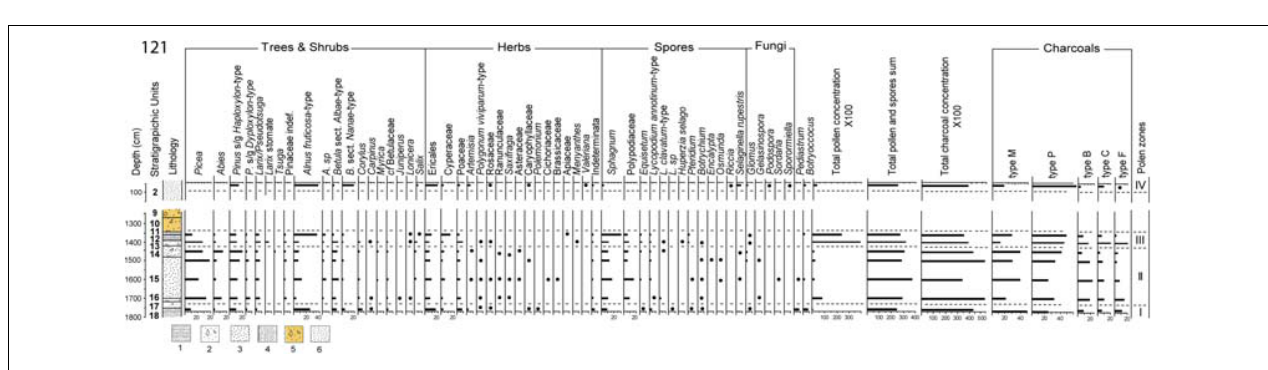
FIGURE 5 | Percentage pollen, spore, and non-pollen-palynomorph diagram of site 120 (for location see Figure 1B ). 1 – greenish-brownish pebble bed with coarse sand and fine-sand loam; 2 – ferruginous pebble bed with coarse sand; 3 – yellowish-green pebble bed with sand; 4 – laminated grayish loess-like fine-sandy loam; 5 – modern sandy soil.